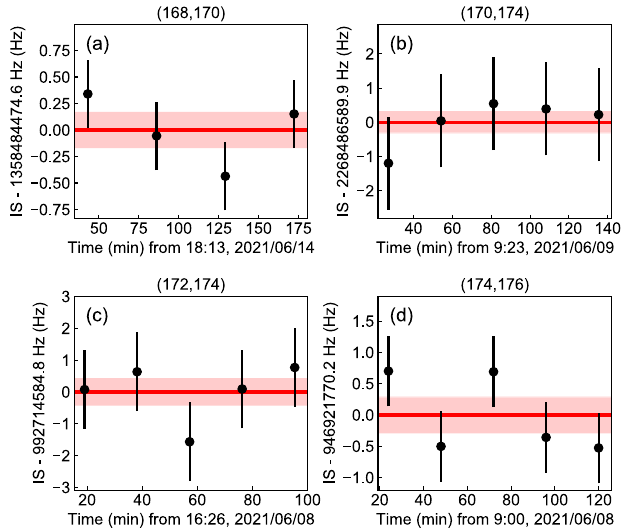
FIG. 2. Stability of interleaved clock operation. 173 Yb atoms 5 = 2 are alternately interrogated with a cycle time of with m F ¼ (cid:3) 5 = 2 ; m 5 = 2 Þ − τ ¼ 136 s by the clock transition 1 S 0 ð F ¼ F ¼ (cid:3) 3 P 5 = 2 ; m 5 = 2 Þ . Vertical and horizontal axes re- 0 ð F 0 ¼ F 0 ¼ (cid:3) present the overlapping Allan deviation and the averaging time, FIG. 4. Systematic effect of lattice light shift. (a) (168,170), respectively. Error bars represent the upper and lower bounds (b) (170,174), (c) (172,174), and (d) (174,176). The horizontal with 1 σ confidence interval. axis represents the total lattice depth in units of E show the 1 σ statistical uncertainties obtained from the over- lapping Allan deviations. We draw red lines as guides to the eye. The origin of the vertical axis corresponds to the unperturbed IS, which is obtained from the fit to the data. The inconsistencies between the uncertainties of Figs. 3(b) and 3(c) and those in Figs. 4(b) and 4(c) at the same operational condition would be ascribed to the small number of measurements in the IS